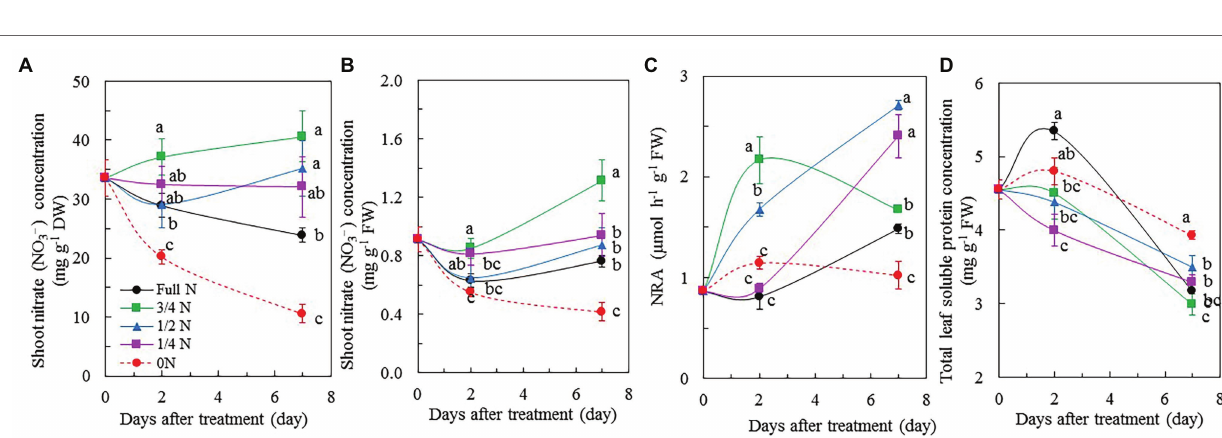
FIGURE 4 | Changes of shoot NO 3– concentration based on dry weight (DW; A ), shoot NO 3– concentration based on FW (B) , nitrate reductase activity (NRA; C ), and total soluble protein (D) of M. crystallinum after different NO 3– treatments. Vertical bars represent the SEs. Means with different letters are statistically different ( p = 0.05; n = 5 for Figures 6A,B ; n = 4 for Figures 6C,D ) as determined by LSD multiple comparison